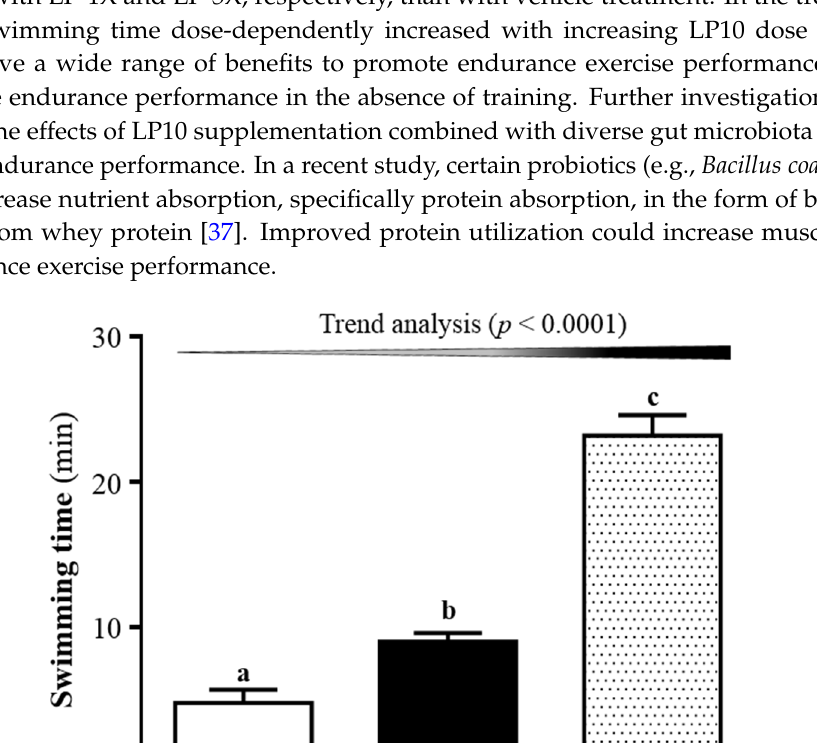
Figure 2. Effects of LP10 supplementation on swimming exercise performance. Mice were pretreated with vehicle, LP10-1X, LP10-5X for six weeks, and then performed an exhaustive swimming exercise with a load equivalent to 5% of body weight attached to the tail. Data are mean ± SEM, n = 8 mice/group, by one-way ANOVA. Different letters (a, b) indicate a significant difference at p < 0.05.